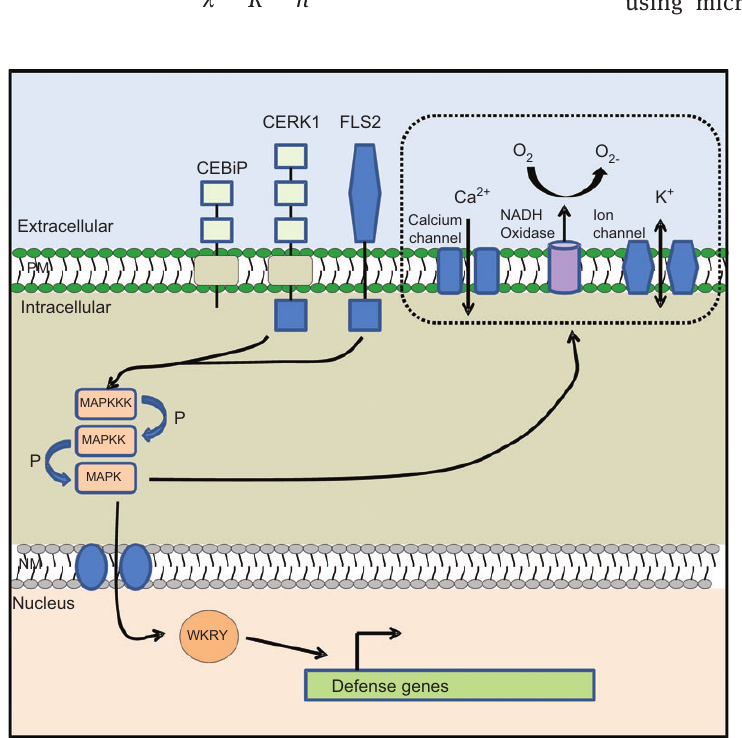
Figure 11 Illustrated summary of PAMP signaling in plant cells. Chitin can bind to the plant cell surface receptors CERK1 and CEBiP, while flagellin can bind to the FLS2 receptor. When these PAMPs bind to their receptors, an MAPK cascade is activated leading to regulation of defense-related genes, influx of calcium, release of potassium ions, and increased ROS